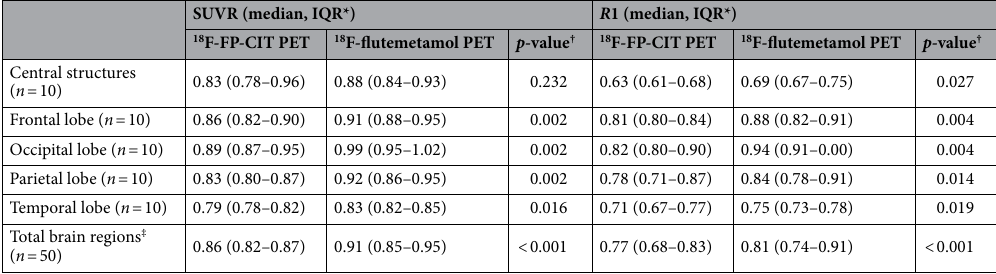
Table 1. Early-phase parameters of 18 F-FP-CIT PET and 18 F-flutemetamol PET. *Interquartile range, † p -value from the Wilcoxon test for paired samples, ‡ regions including central structures and all cerebral lobes.